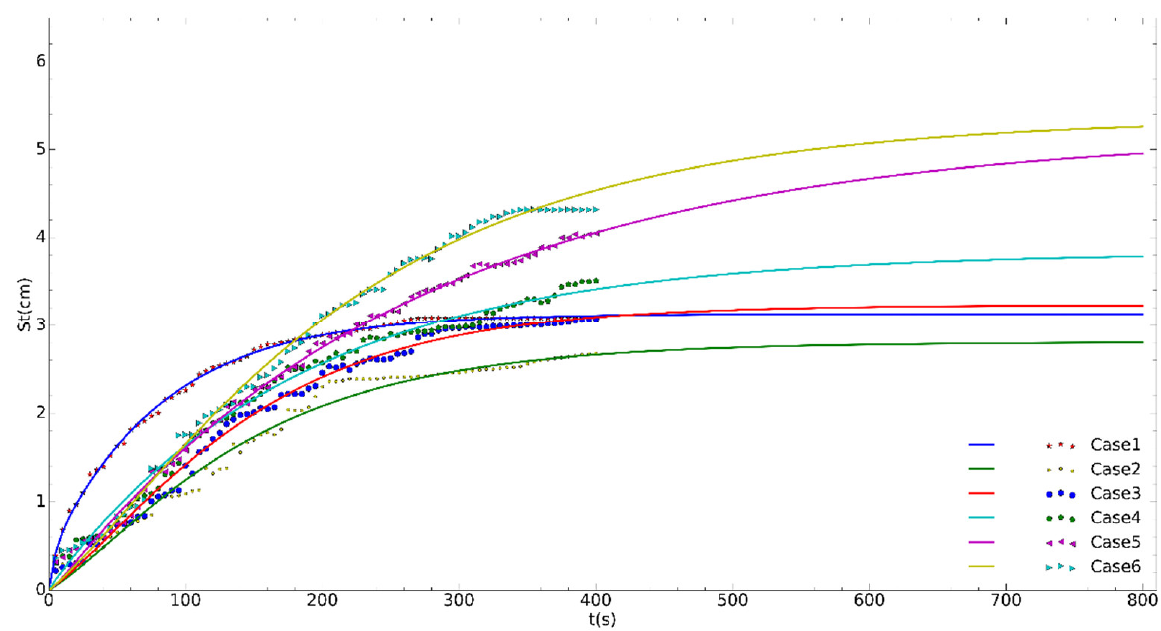
Figure 9. The fitted curve of the maximum scouring depth of each case in 800 s. Table 3. The parameters in the function.